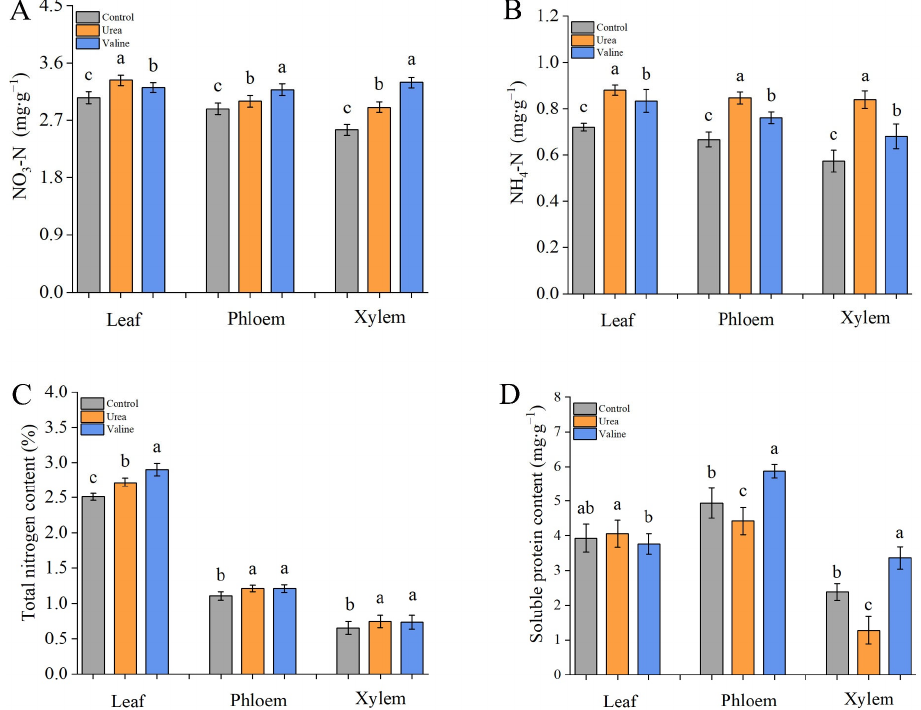
Figure 6. Effects of valine and urea on nitrogen metabolites in peach tree. ( A ) NO3-N content. ( B ) NH4-N content. ( C ) Total nitrogen content. ( D ) Soluble protein content. The error bar represents the standard deviation of the mean ( n = 3). Samples were tested on day 60 after valine and urea treatment. Different lowercase letters indicate significant differences among treatments (Duncan test, p < 0.05).